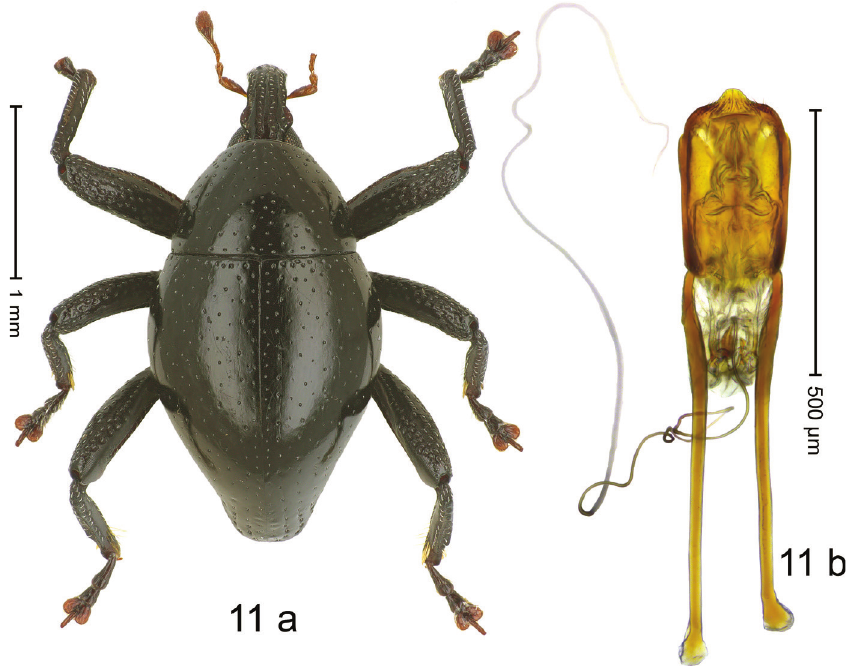
Figure 11. Trigonopterus katopasaensis sp. nov., holotype a habitus b